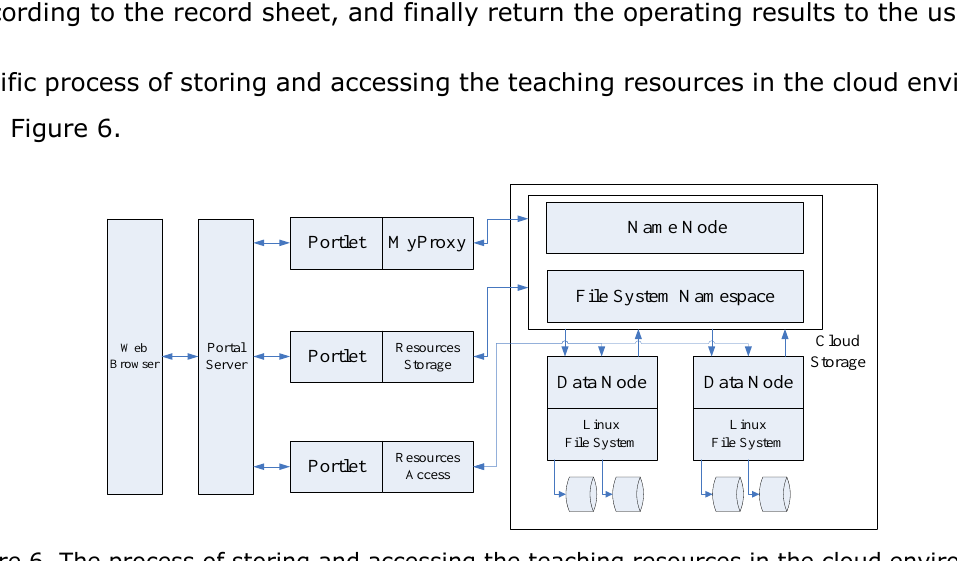
Figure 6. The process of storing and accessing the teaching resources in the cloud environment